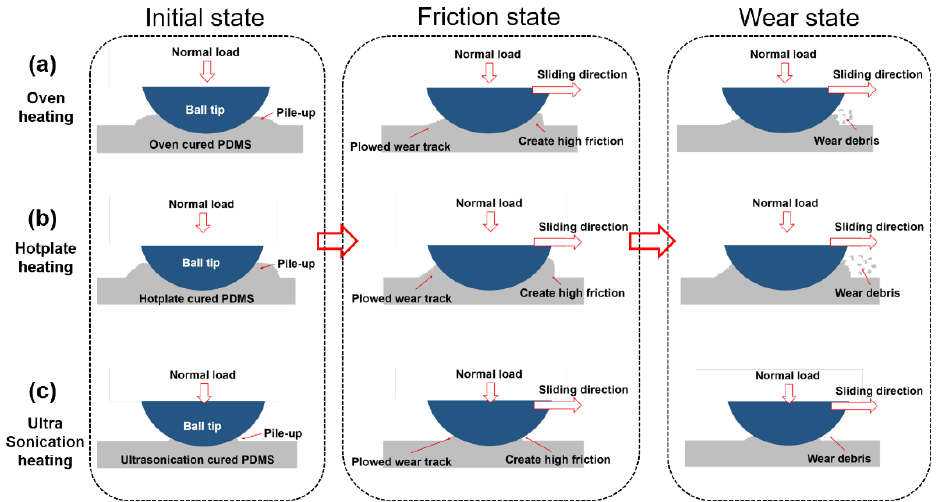
Figure 7. Initial contact state and friction/wear mechanism of the PDMS thin films cured by the ( a ) oven, ( b ) hotplate, and ( c ) ultrasonication curing